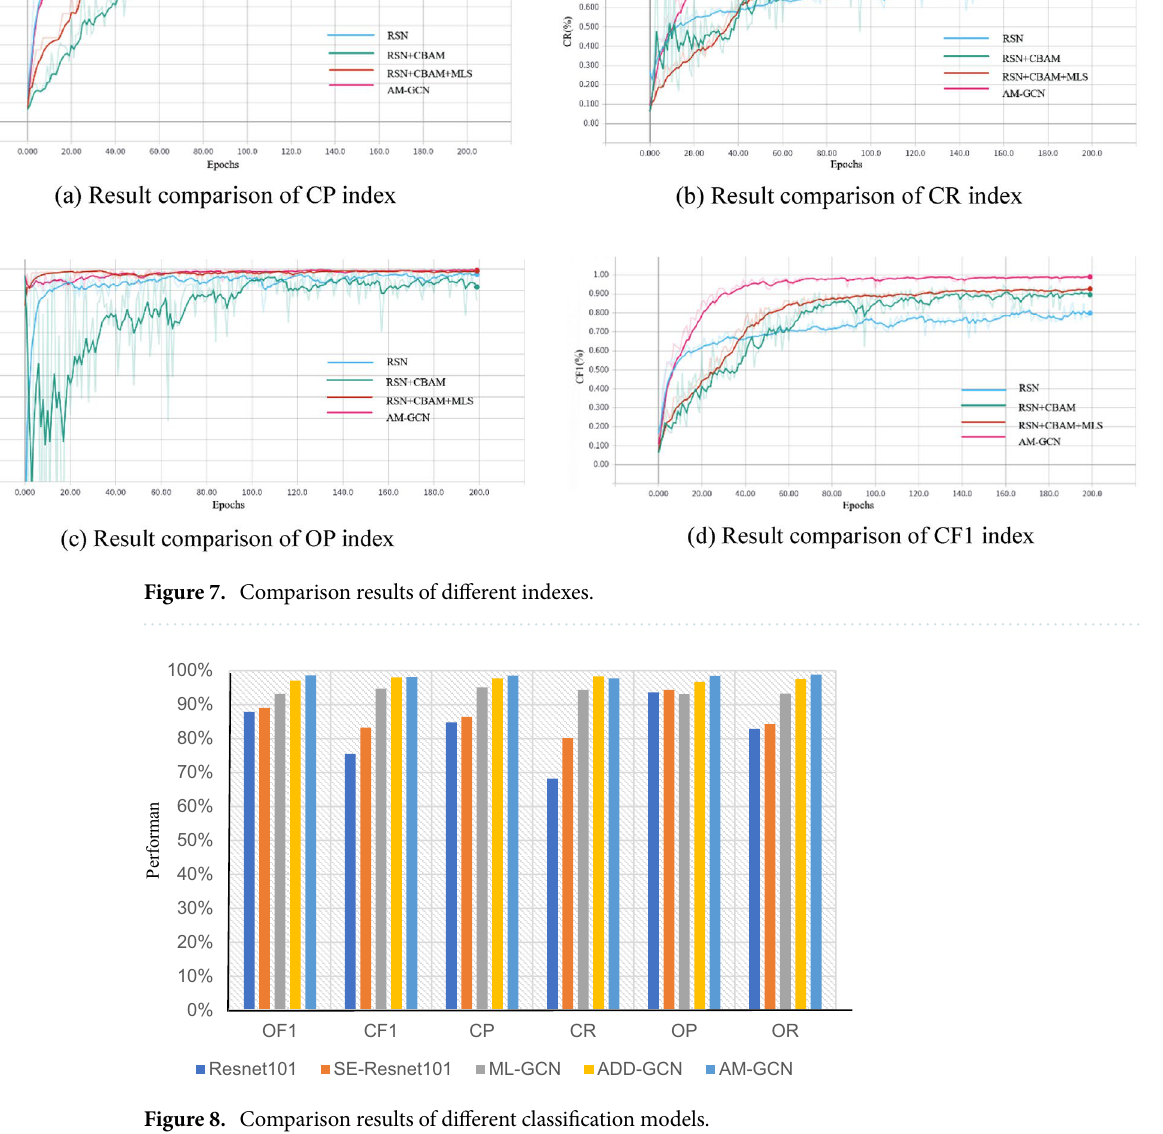
Figure 8. Comparison results of different classification